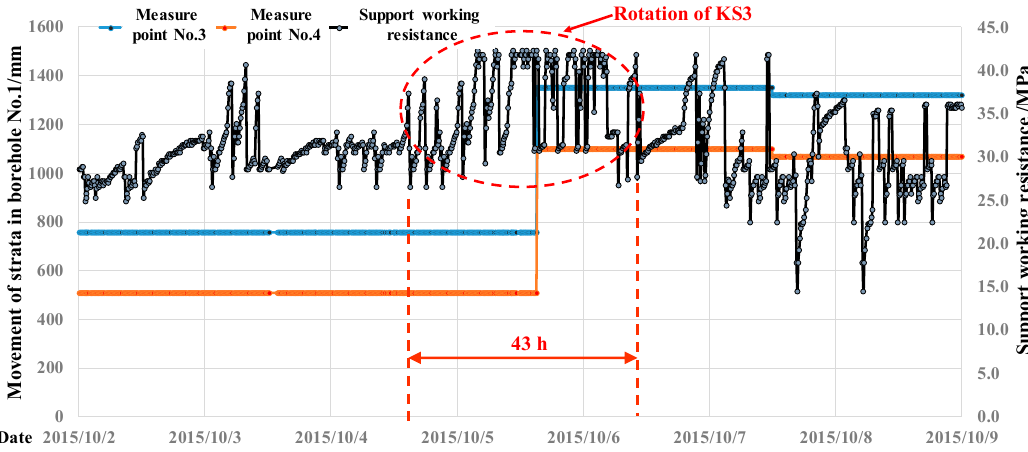
Figure 6. Resistances in No. 55 support along the rotations of KS3.